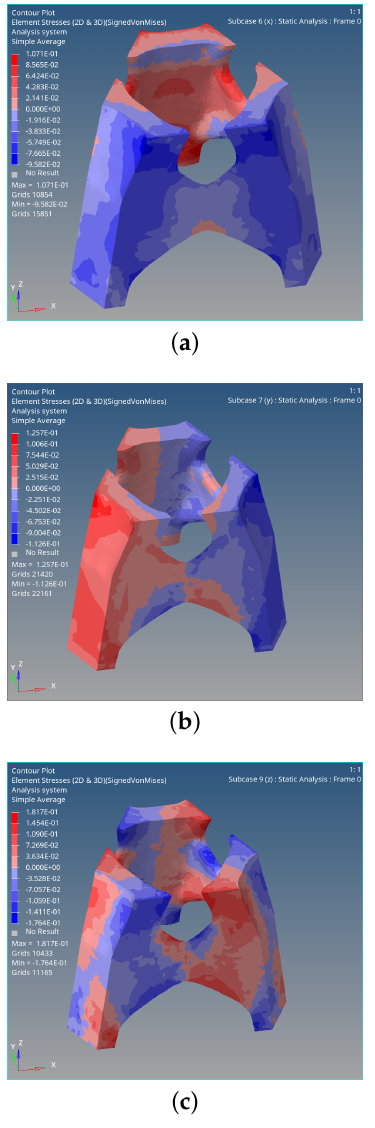
Figure 5. Stress nephogram of the elastomer with topological structure. ( a ) x axis direction. ( b ) y axis direction. ( c ) z axis